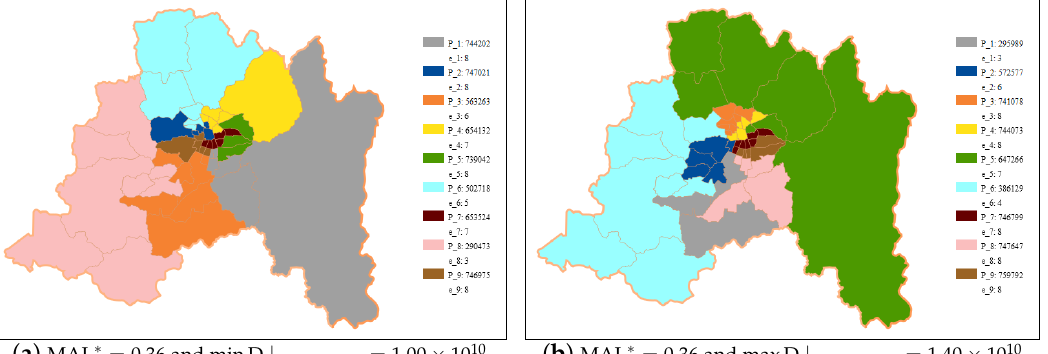
Figure 3. Districting designs for the Metropolitana region: Opposite performances of compactness for MAL ∗ =